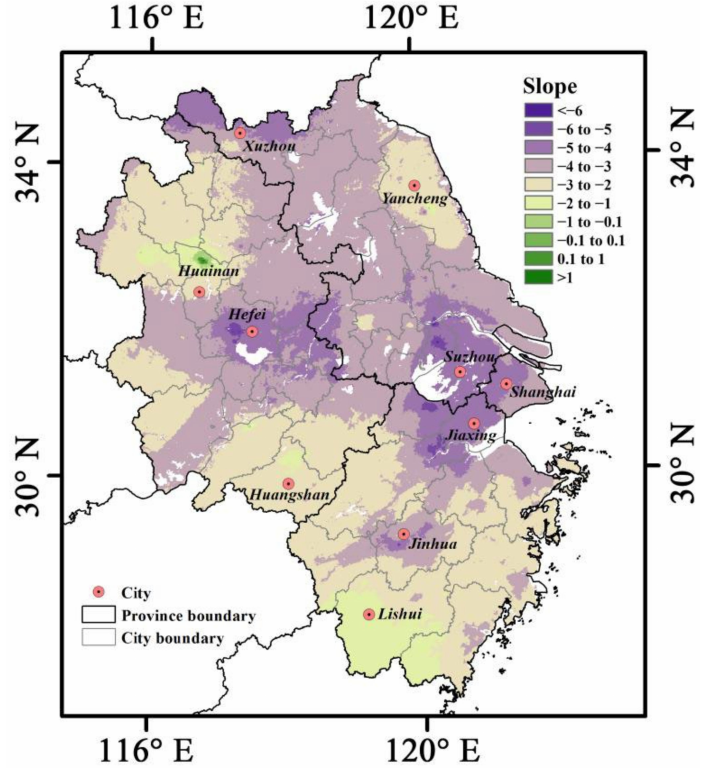
Figure 5. Trends in PM 2.5 concentrations in the